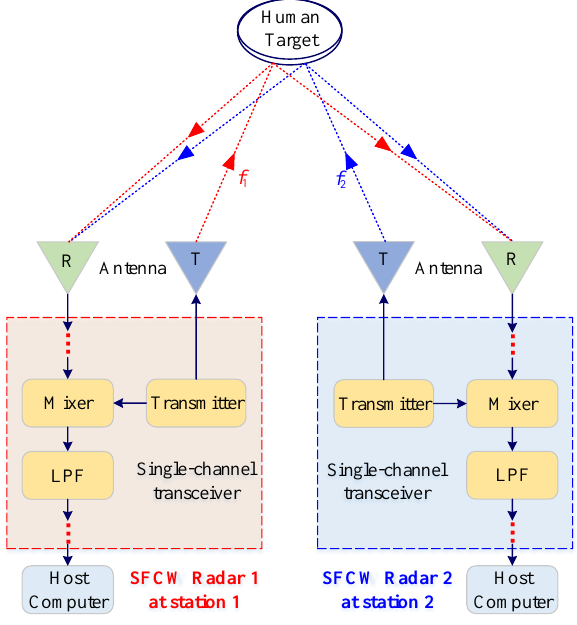
Figure 1. Dual-station SFCW